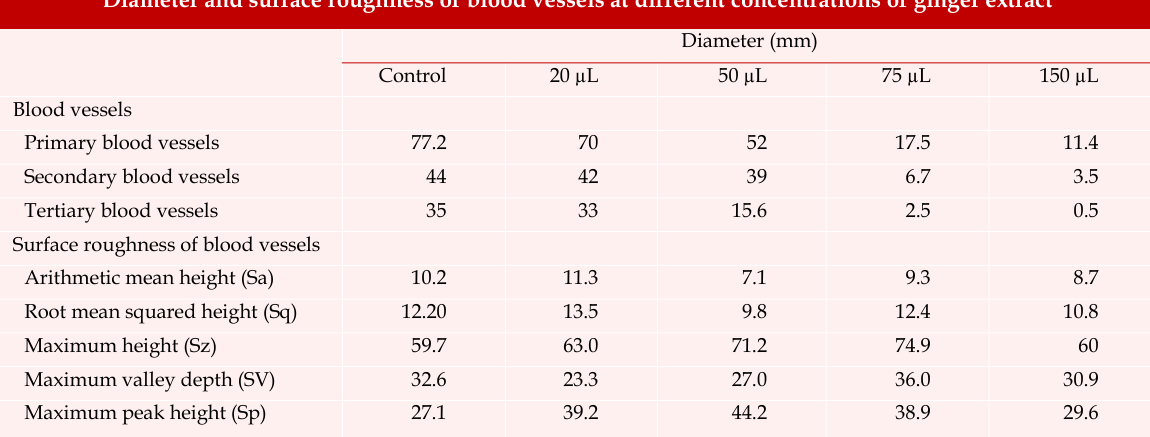
Diameter and surface roughness of blood vessels at different concentrations of ginger